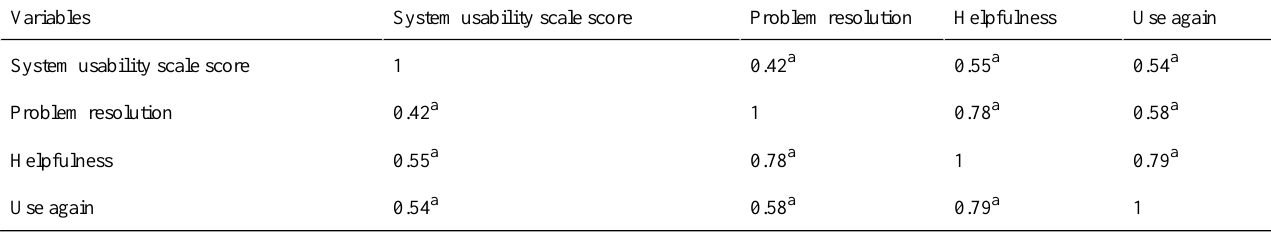
Table 3. Pearson Correlations for postintervention Manage Your Life Online ratings of system usability, problem resolution, helpfulness, and willingness to use Manage Your Life Online again.